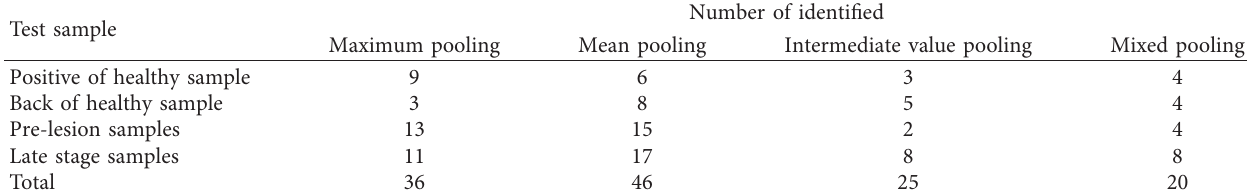
Table 1: Identification of strawberry diseases by different pond effects.